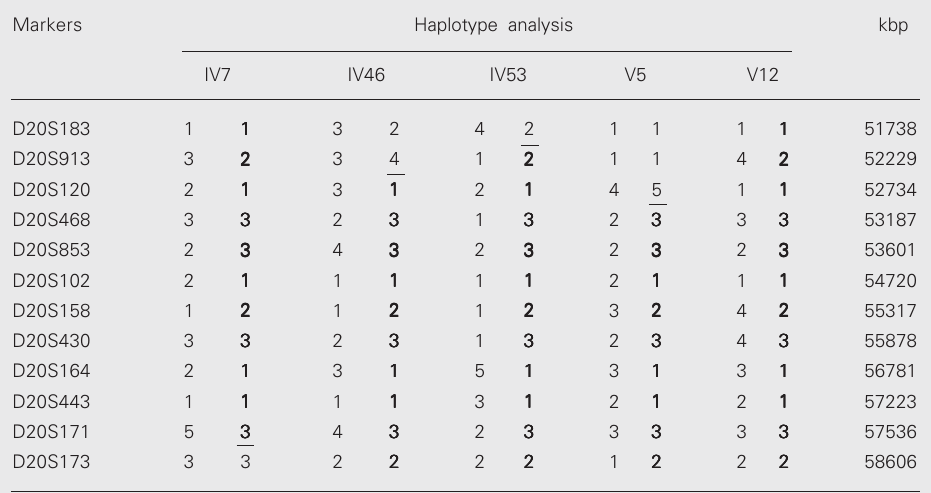
Table 2. Haplotype and genotypic analysis of ten additional markers in five family members in whom a recombination event had been previously identified.